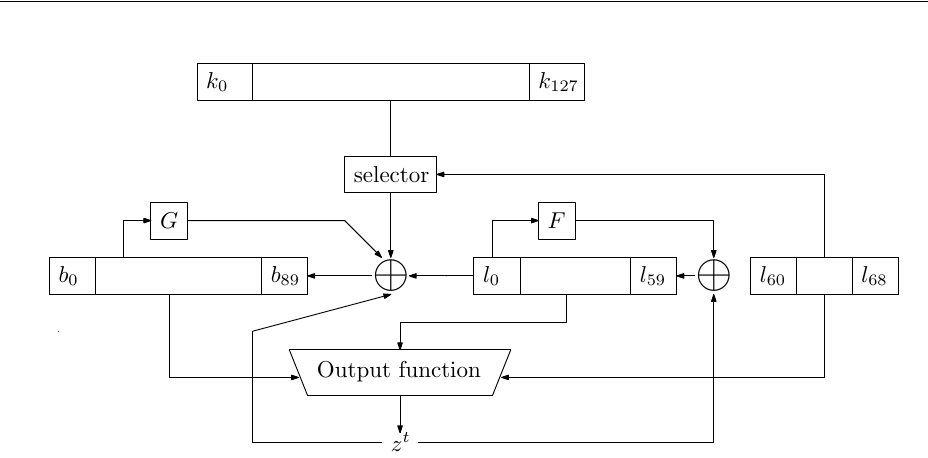
Figure 2: Illustration of the initialization